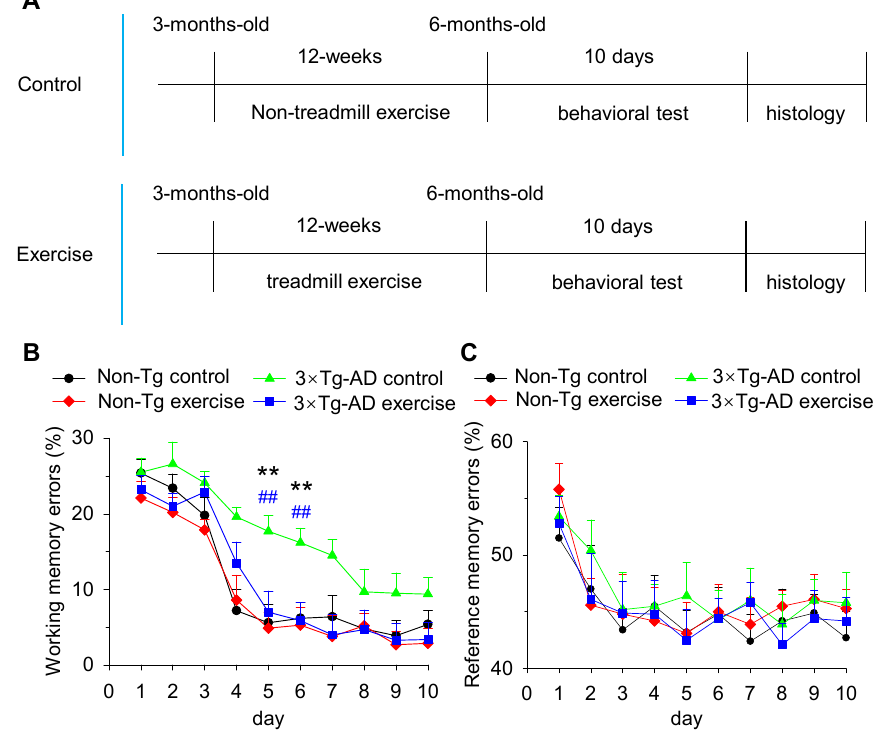
Figure 1. Treadmill exercise prevents decline in spatial learning and memory in 3 × Tg-AD mice. ( A ) Timeline of treadmill exercise or non-exercise control, behavioral test and histological test. ( B ) The percentage of working memory errors on day 5 and day 6 was significantly increased in the 3 × Tg-AD mice compared to the Non-Tg control group ( B ; ** p < 0.01, n = 10 mice). The increase in the percent- age of working memory errors was prevented by treadmill exercise pretreatments ( B ; ## p < 0.01, n = 10 mice). ( C ) There were no significant effects on the percentage of reference memory errors between Non-Tg control, Non-Tg exercise, 3 × Tg-AD control, and 3 × Tg-AD exercise mice ( C ; p > 0.05, n = 10